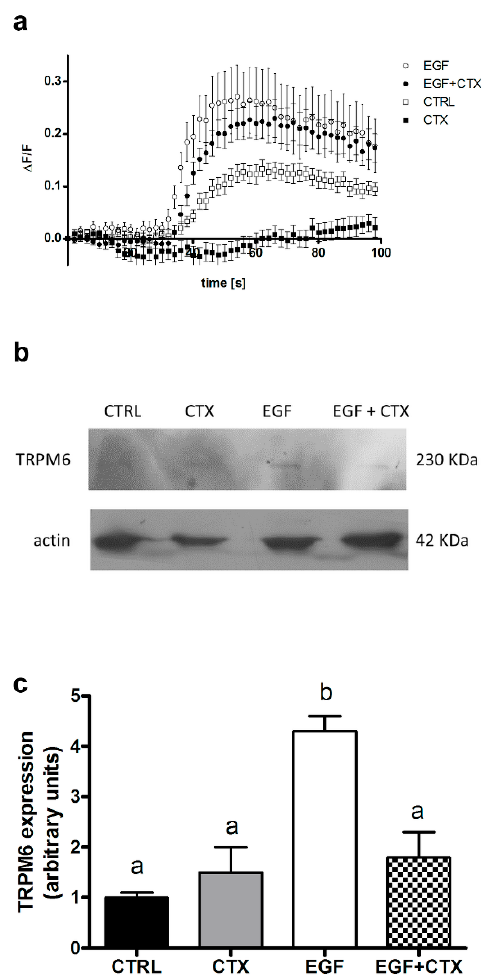
Figure 2. Epidermal growth factor (EGF) stimulates TRPM6 channel expression and Mg influx in human colon carcinoma cells. CaCo-2 cells were serum-starved for 24 h and exposed to EGF (10 ng/mL) and cetuximab (CTX, 70 μ g/mL), either alone or in combination, for a further 24h. ( a ) Mg influx capacity, as assessed by the live imaging of Mag-Fluo-4-loaded cells; a representative experiment is shown. ( b ) TRPM6 protein expression, as evaluated by Western blot analysis; a representative blot is shown. ( c ) Quantification of TRPM6 protein expression by Western blot densitometry normalized to β -actin levels ( n = 3, mean ± SD). Data sharing the same letter are not significantly different ( p > 0.05) according to one-way ANOVA, followed by Bonferroni’s test. Full scans of original blots are available in Figure S2.